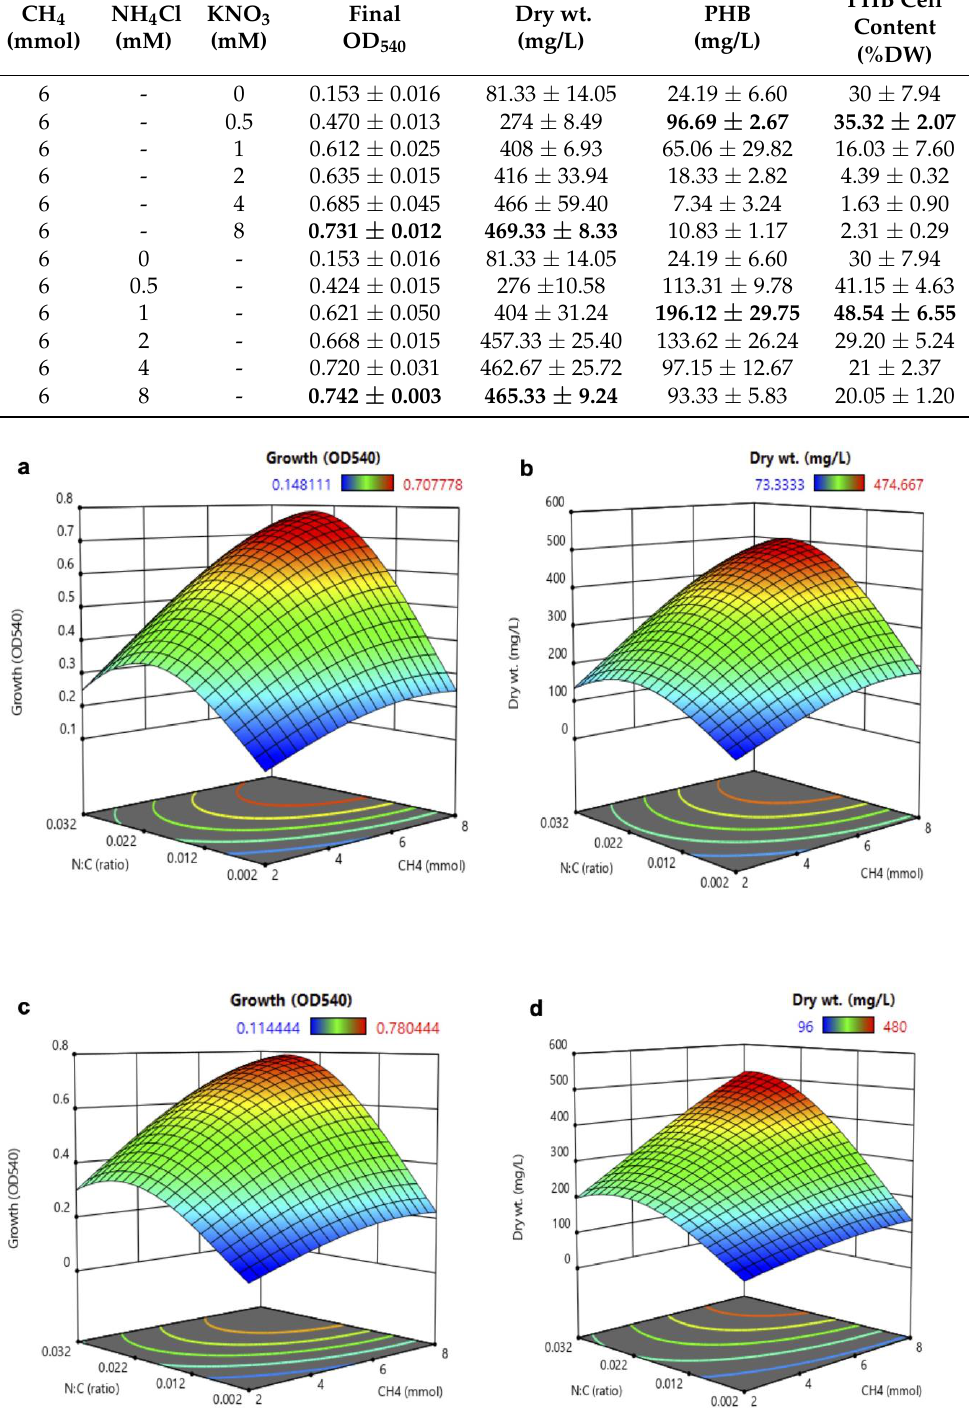
Figure 1. RSM results for growth (OD = 540 nm) and biomass (Dry weight in mg/L) in stationary phase batch cultures of Methylocystis sp. Rockwell grown with varying amounts of methane against varying N:C ratios. Results are shown for cultures grown in NMS ( a , b ) and AMS ( c , d ) media ( n = 3).